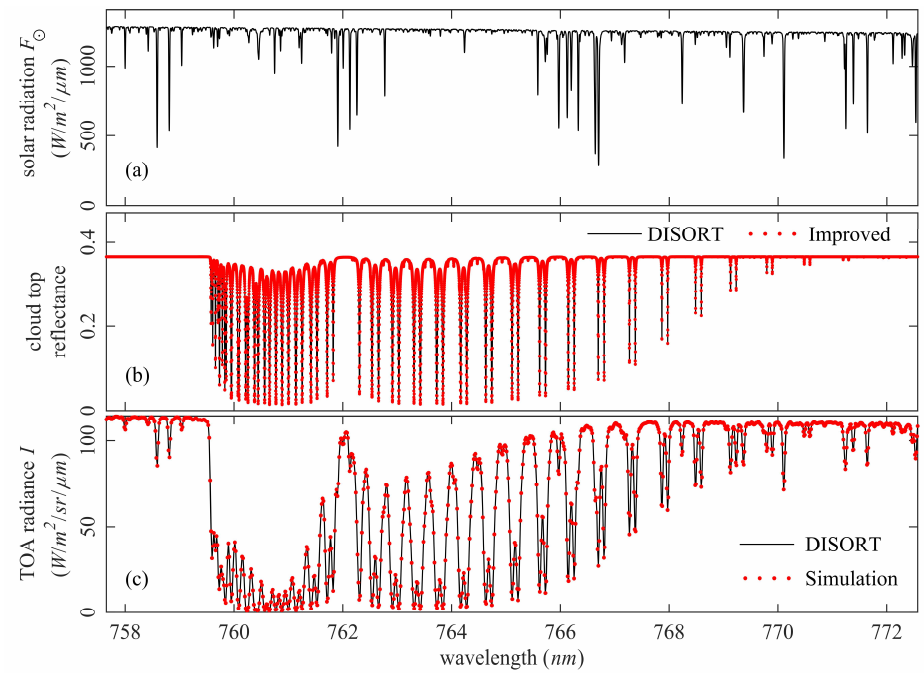
Figure 7. An example of hyperspectral simulations at the top of the atmosphere. ( a ) Solar radiation at the top of the atmosphere. ( b ) The cloud reflectance calculated by the physical parameterization and compared with the precise reflectance from DISORT. ( c ) The simulated hyperspectral radiance at the top of the atmosphere. The cloud optical depth is 7, the cloud-top height is 1.25 km, the cloud geometrical thickness is 0.5 km, and the solar zenith angle is 40°.